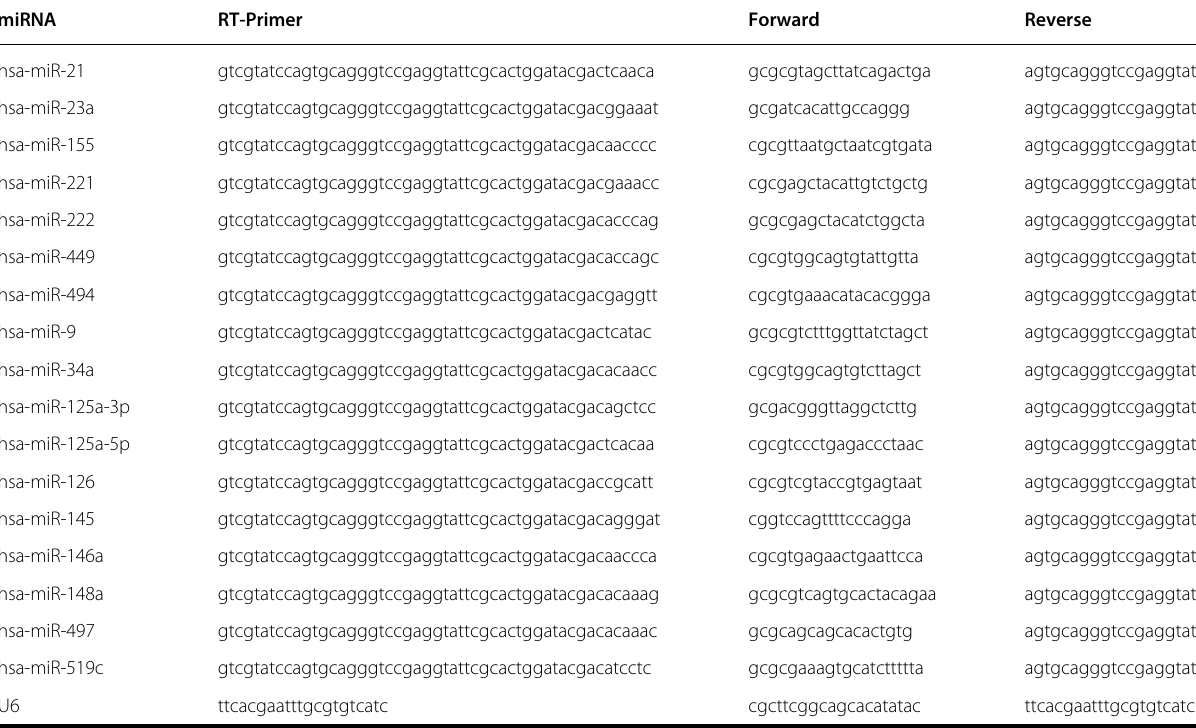
Table 1 The sequences of several miRNA primers.